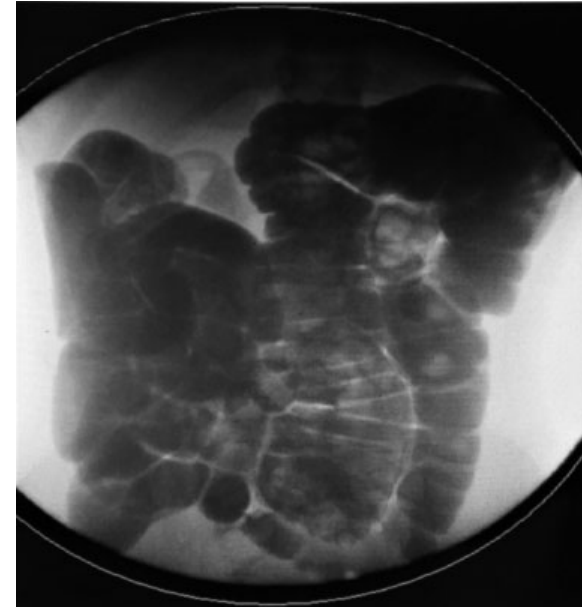
Fig. 3 Case 2: Lower GI contrast study done after US abdomen showing large bowel on the left side and small bowel on the right side of the abdomen. GI, gastrointestinal tract; US, ultrasound.